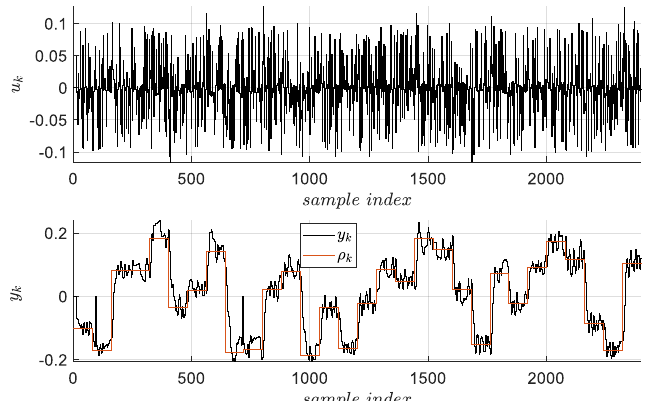
Figure 2. I/O data collected from the closed-loop visual servo system.